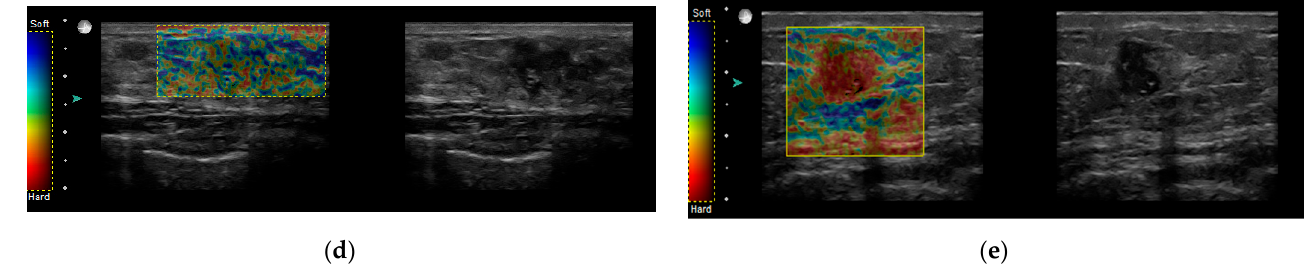
Figure 1. Sonoleastography. Shear wave elastography (SWE), ( a – c ) examples of tumors. ( a ) 65-year patient with TNBC, soft in elastography (E max 13.5 kPa). ( b ) 52-year patient with LB breast cancer, intermediate stiffness (E max 129.5 kPa). ( c ) 67-year patient with HER2+ breast cancer, stiff on elastography (E max 240 kPa). Strain elastography (SE), ( d , e ) examples of tumors. ( d ) 32-years patient with subtype LB HER2+ breast cancer, Tsukuba1. ( e ) Ultrasound examination in a 65-years old patient with TNBC, Tskububa5. LB HER2+ = luminal B with HER2 overexpression; HER2+ = human epidermal growth factor receptor 2 positive; TNBC = triple negative breast cancer.